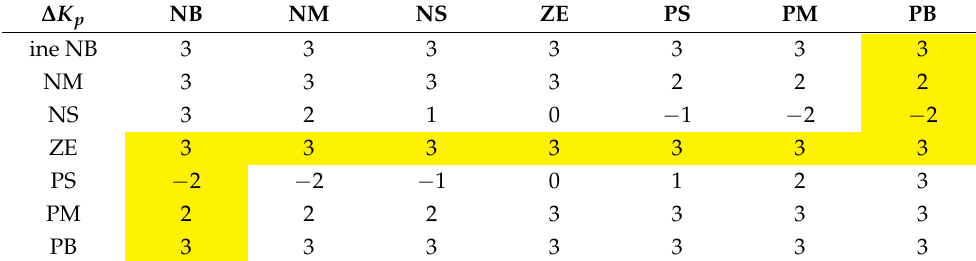
Table 2. Fuzzy rule base of ∆ K p (yellow background are the cells of sparse rule bases).